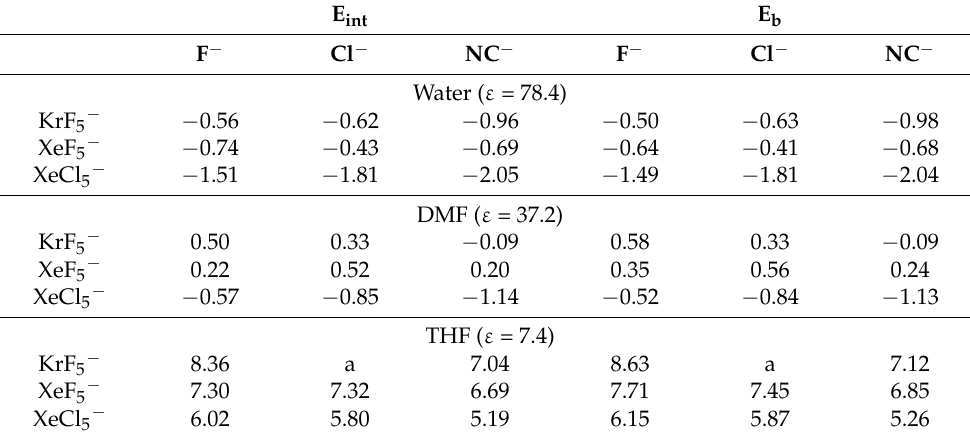
Table 3. Interaction energy E int and binding energy E b of AeX 5 −· ·· An − complexes calculated in different solvents at the MP2/aug-cc-pVDZ level of theory. All values in kcal/mol, corrected for